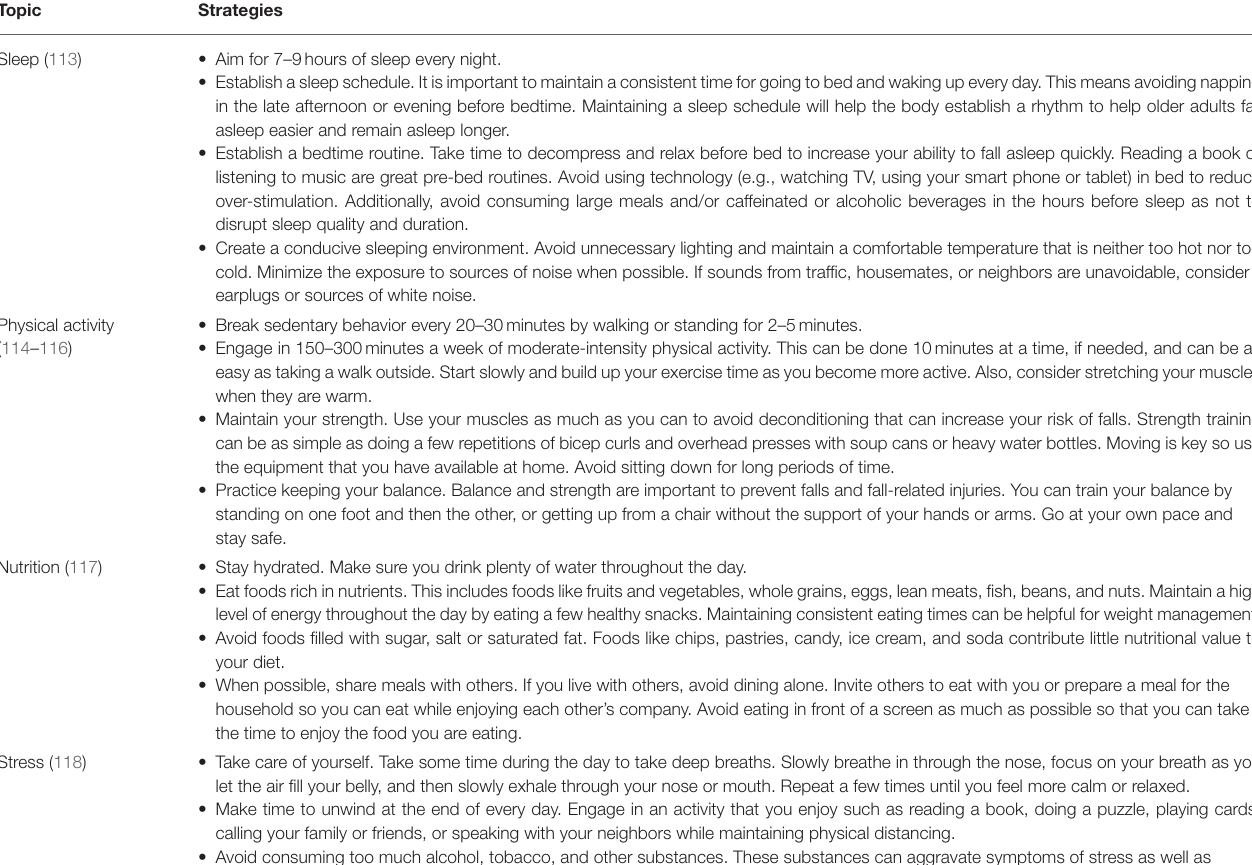
TABLE 1 | Practical recommendations for low-income older